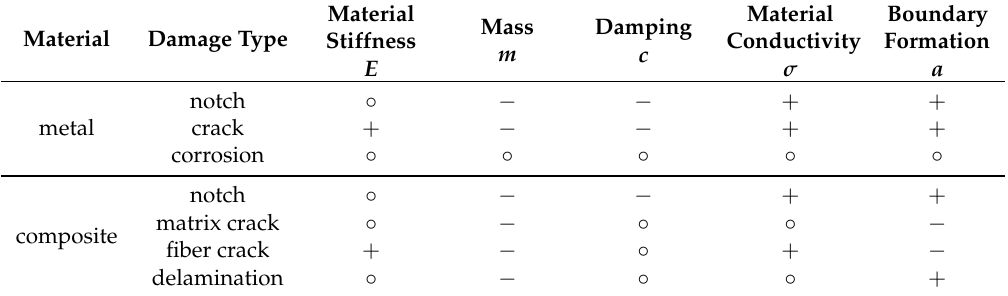
Table 1. Influence of damages on local properties of mechanical structures [14,25–28]: ( + ) strong, ( ◦ ) average and ( − ) weak